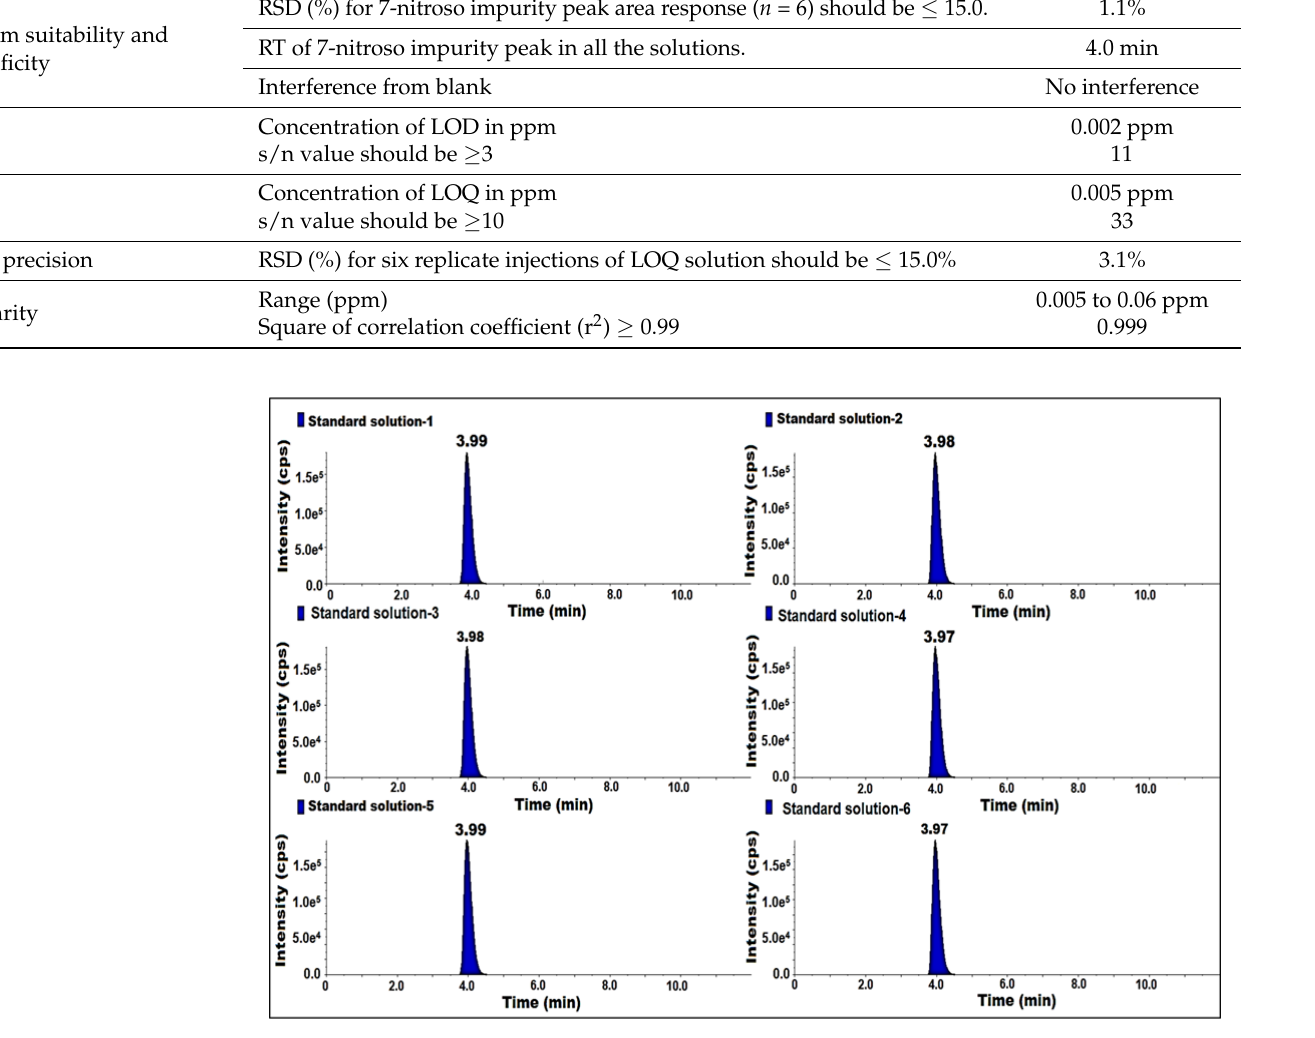
Figure 3. MS/MS MRM chromatogram of the system suitability standard.